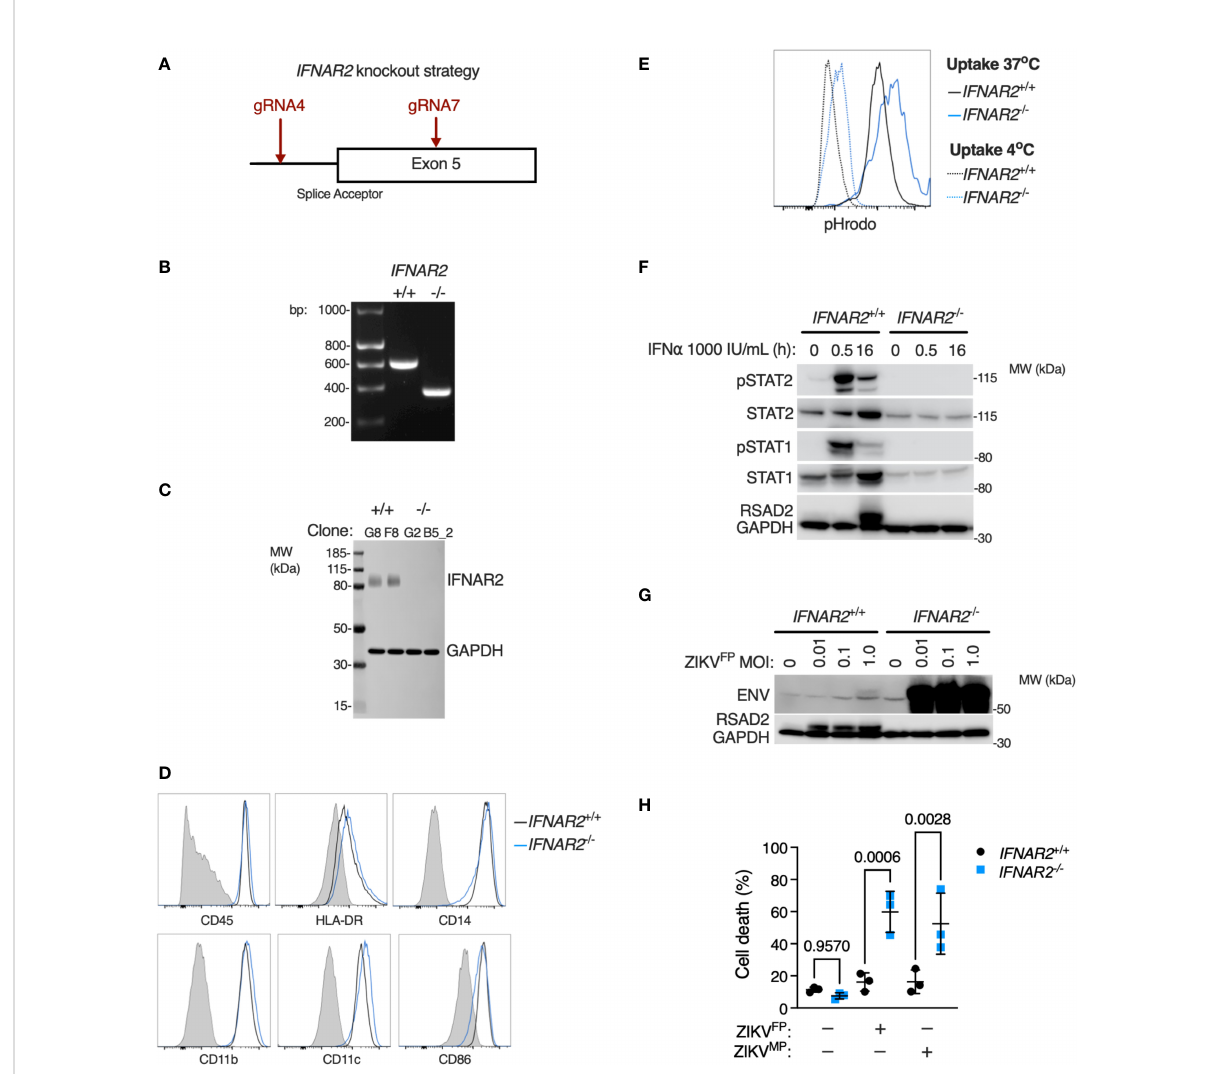
FIGURE 7 IFNAR2 knockout in wild-type iPS-macrophages recapitulates heightened ZIKV replication and cytopathicity. (A) CRISPR/Cas9 guide design. (B) PCR of IFNAR2 amplicon demonstrating exon 5 splice acceptor site excision in iPSC clones (G8 and G2). Representative of experiments in clones F8 and B5_2. (C) Immunoblot of IFNAR2 and GAPDH expression, demonstrating IFNAR2 ablation in iPS-M f clones (G8, F8, G2, B5_2). Representative of n=2 independent experiments. (D) Expression of macrophage surface markers in IFNAR2 -/- (B5_2) and IFNAR2 +/+ (F8) iPS-M f by fl ow cytometry, representative of repeat experiments in F8/B5_2. (E) Phagocytic uptake of Zymosan pHrodo particles in IFNAR2 -/- (B5_2) and IFNAR2 +/+ (F8) iPS-M f by fl ow cytometry, representative of repeat experiments in F8/B5_2. (F) Immunoblot of IFN-I signalling in IFN a 2b (1000 IU/mL) treated IFNAR2 -/- (B5_2) and IFNAR2 +/+ (F8) iPS-M f , representative of n = 3 independent experiments. (G) Immunoblot of ENV, RSAD2 and GAPDH expression in IFNAR2 -/- (B5_2) and IFNAR2 +/+ (F8) iPS-M f , 72 h.p.i. post infection, representative of n=3 independent experiments. (H) CellPro fi ler quanti fi cation of cell viability assay in IFNAR2 -/- (G2, B5_2) and isogenic IFNAR2 +/+ (G8, F8) iPS-M f (72 h.p.i. ZIKV FP or ZIKV MP MOI = 1.0, n = 3 independent experiments). Mean ± SD, ANOVA with Sidak ’ s test for multiple